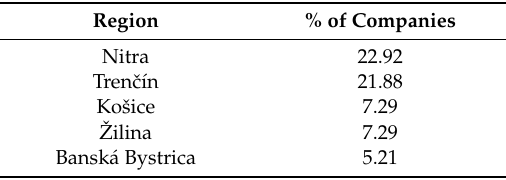
Table 1. Companies according to the